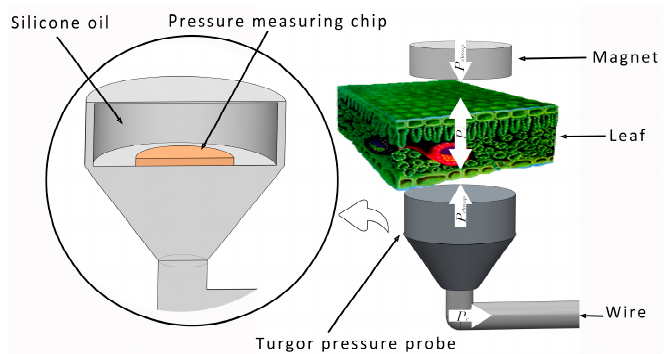
Figure 1. Sensor system structure diagram.